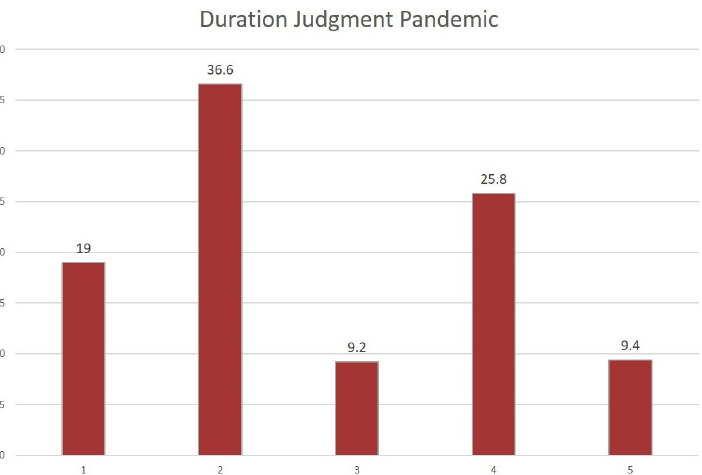
Fig 2. Proportions of selected options (in percents) for the experienced duration over the preceding 14 months. Values ranged from 1 = a lot shorter to 5 = a lot longer than usual 14 months.